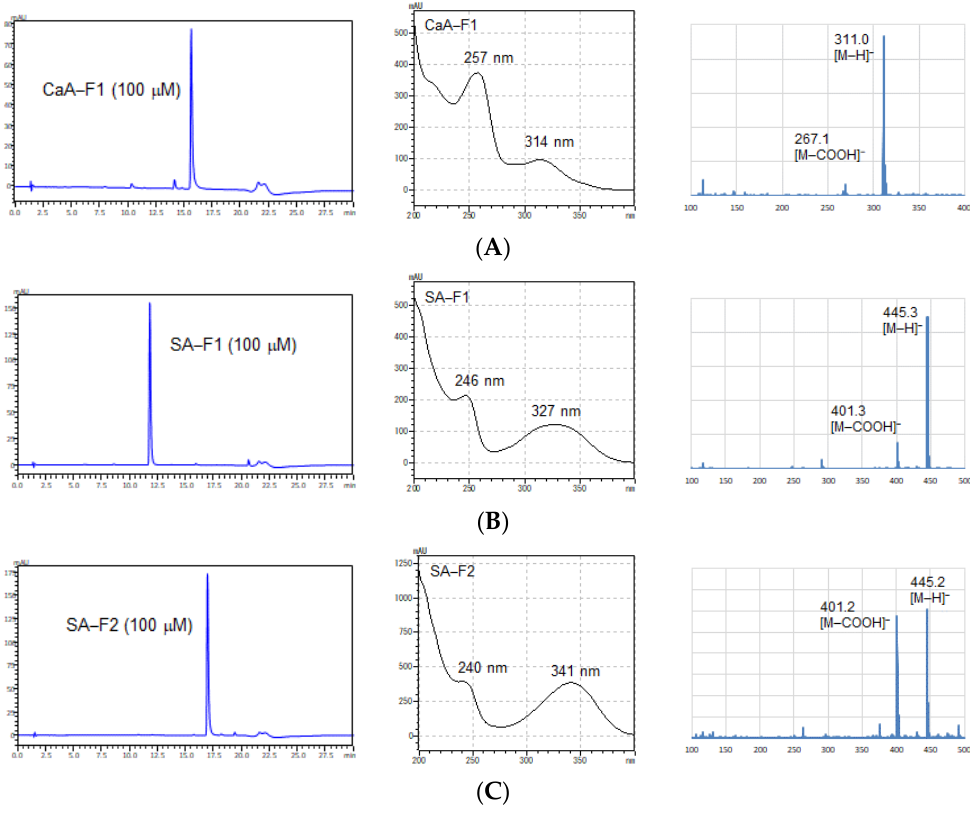
Figure 3. ( Left ) Chromatograms, ( center ) wavelengths, and ( right ) mass spectra of ( A ) CaA-F1, ( B ) SA-F1, and ( C ) SA-F2.